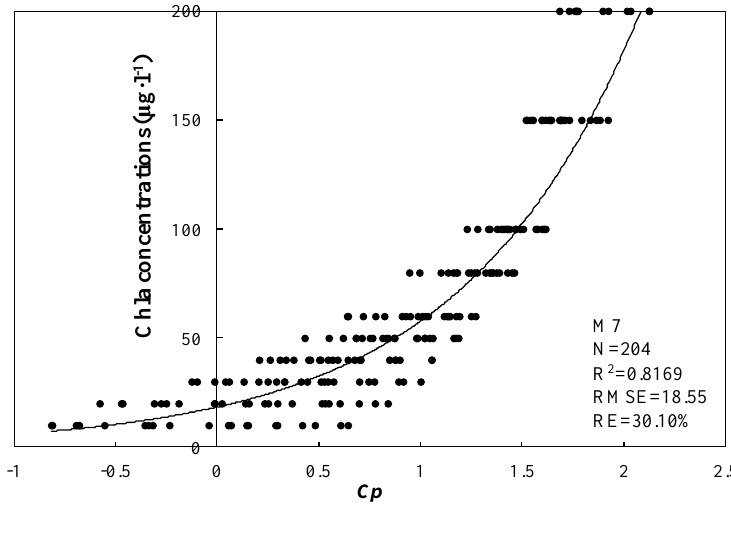
Figure 4. The relationship between the decomposition coefficients of phytoplankton ( C and Chla based on Hydrolight simulated